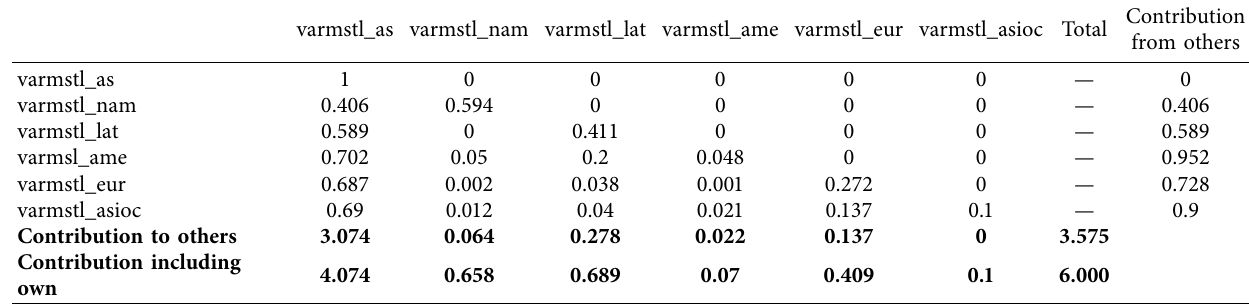
Table 9: Total influence of global synchronization network. Panel A: 1-month-ahead forecast-error variance decomposition